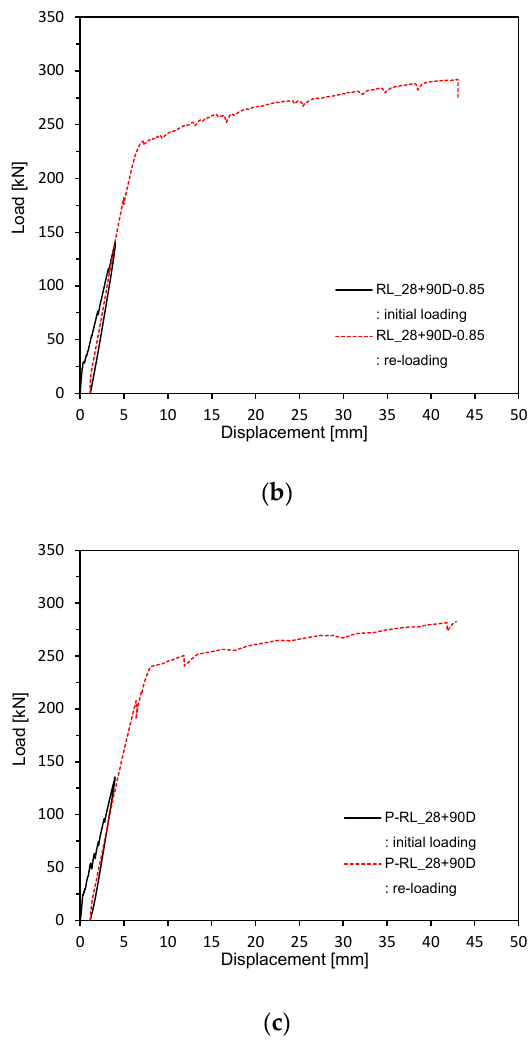
Figure 12. Load-deflection measurement after 28 + 90 days (up to ultimate load after pre-loading and additional 90 days of curing after pre-loading): ( a ) 2.5 series; ( b ) 0.85 series; ( c ) Plain series.